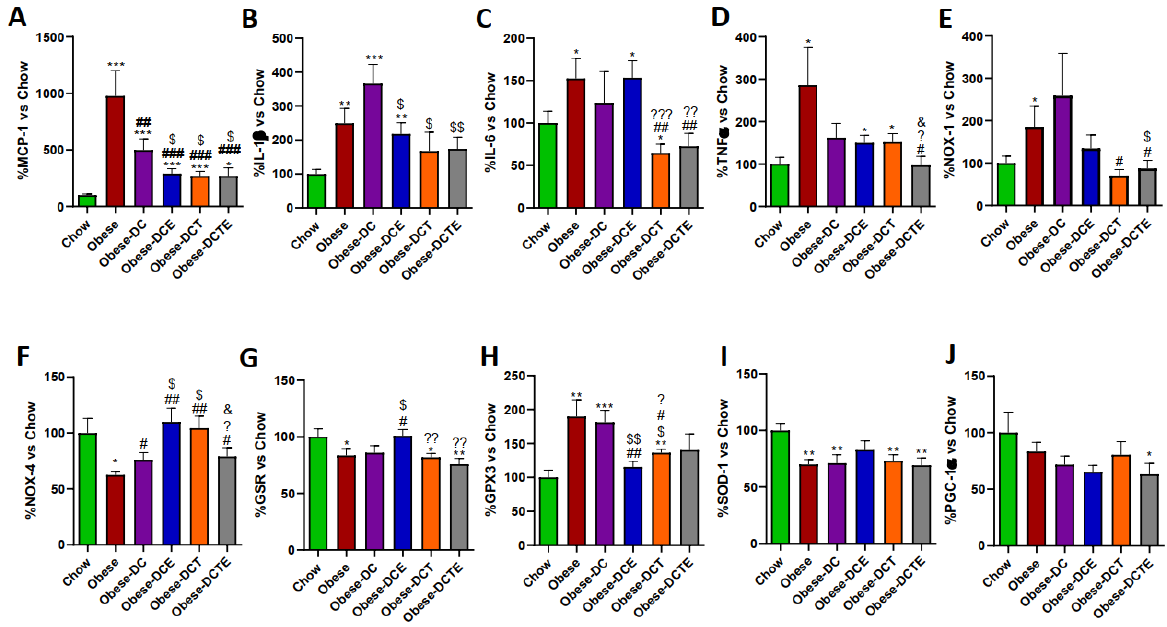
Figure 4. Hepatic gene expression of Monocyte Chemotactic Protein-1 ( A ), Interleukin 1 β ( B ), Inter- leukin 6 ( C ), Tumor Necrosis Factor α ( D ) NADPH oxidase 1 ( E ), NADPH oxidase 4 ( F ), Glutathione Reductase ( G ), Glutathione Peroxidase 3 ( H ), Super Oxide Dismutase 1 ( I ) and PPAR- γ coactivator 1 α ( J ). Chow = mice fed a standard diet for 25 weeks; Obese = mice fed a high fat (60% kcal from fat)/high sucrose diet for 25 weeks; DC = mice fed a high fat (60% kcal from fat)/high sucrose diet for 23 weeks and switched to a diet with lower caloric intake (25% kcal from fat) for two weeks; DCE = mice fed a high fat (60% kcal from fat)/high sucrose diet for 23 weeks and switched to a diet with lower caloric intake (25% kcal from fat) supplemented with CSAT+ ® for two weeks; DCT = mice fed a high fat (60% kcal from fat)/high sucrose diet for 23 weeks and switched to a diet with lower caloric intake (25% kcal from fat) and subjected to aerobic training for two weeks; DCTE = mice fed a high fat (60% kcal from fat)/high sucrose diet for 23 weeks and switched to a diet with lower caloric intake (25% kcal from fat) supplemented with CSAT+ ® and subjected to aerobic train- ing for two weeks. Values are represented as mean ± SEM; n = 8–10 mice/group. * p < 0.05 vs. chow; ** p < 0.01 vs. chow; *** p < 0.001 vs. chow; # p < 0.05 vs. obese; ## p < 0.01 vs. obese; ### p < 0.001 vs.